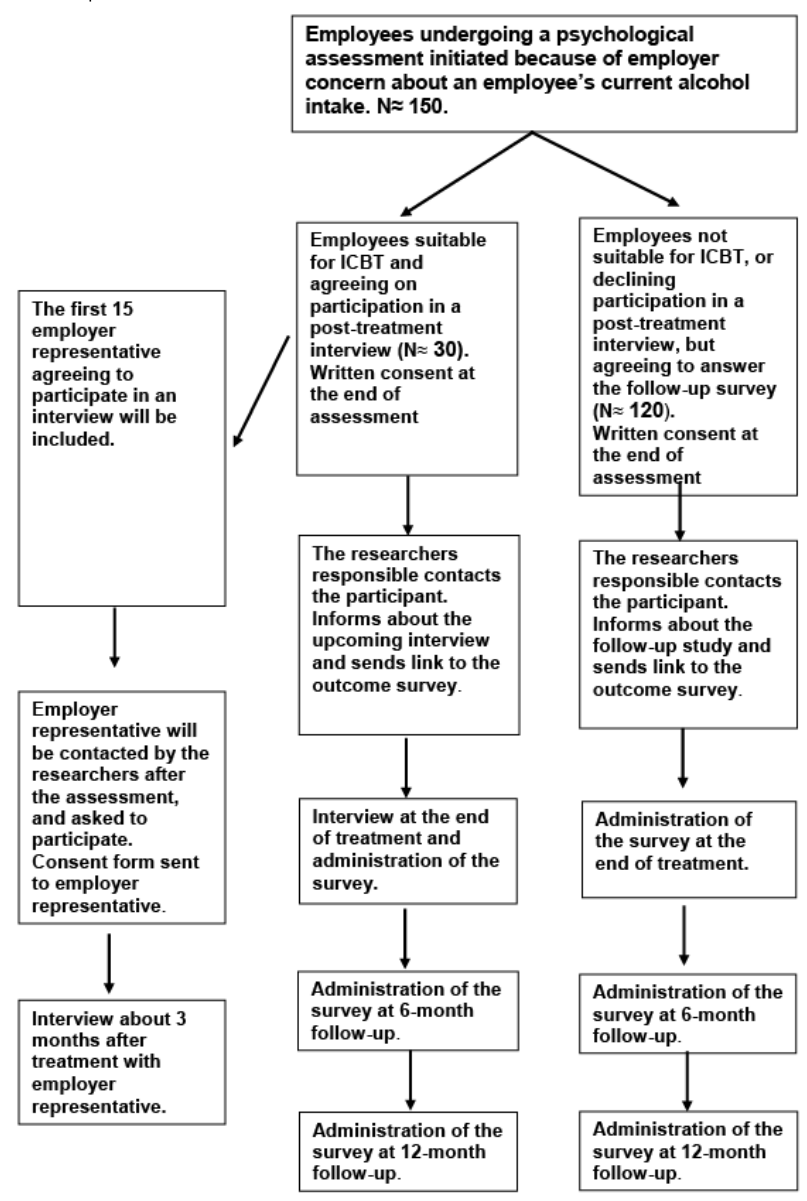
Figure 1. Flowchart for recruitment